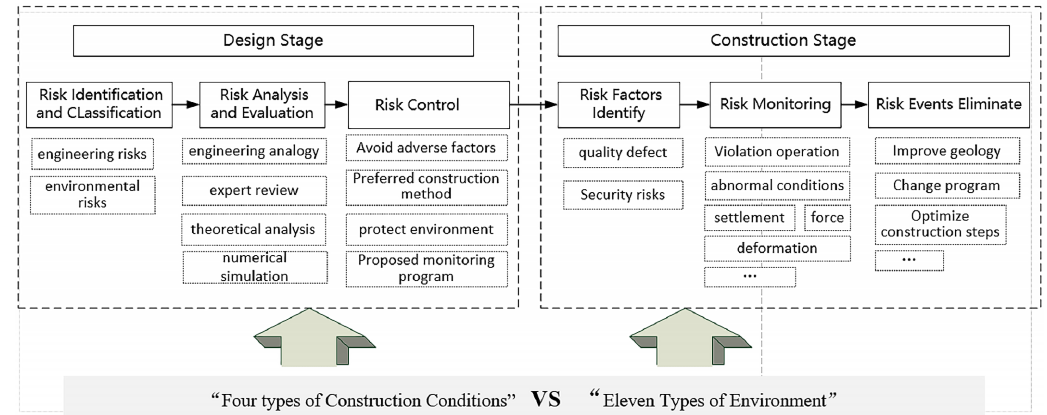
Figure 2. Framework of the safety risk management system for a subway project in